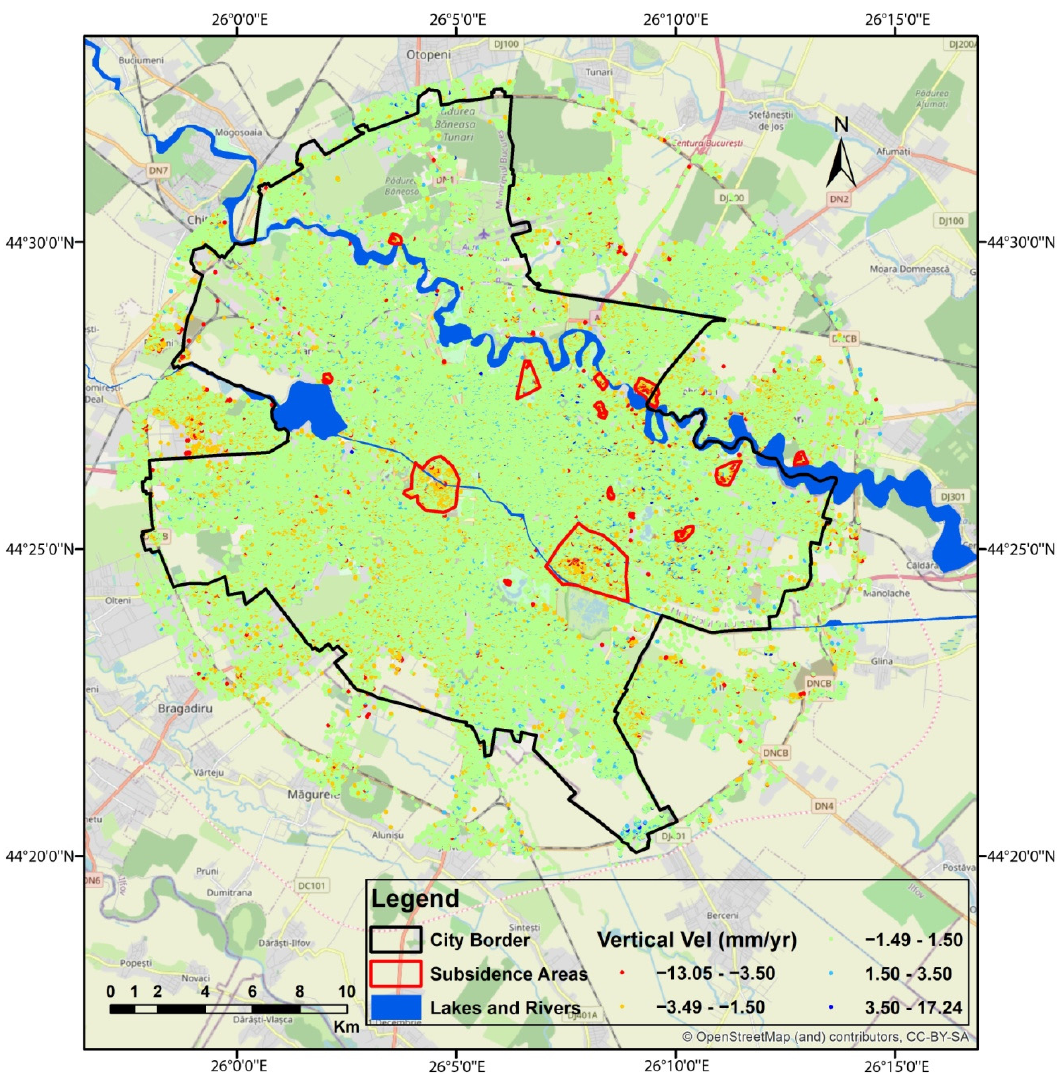
Figure 7. Vertical displacements map of Bucharest city generated by using Sentinel-1 131 Ascending orbit acquisitions and Sentinel-1 109 Descending orbit acquisitions. Map generated in Esri ® ArcMap™ 10.3. Base map source: OpenStreetMap.